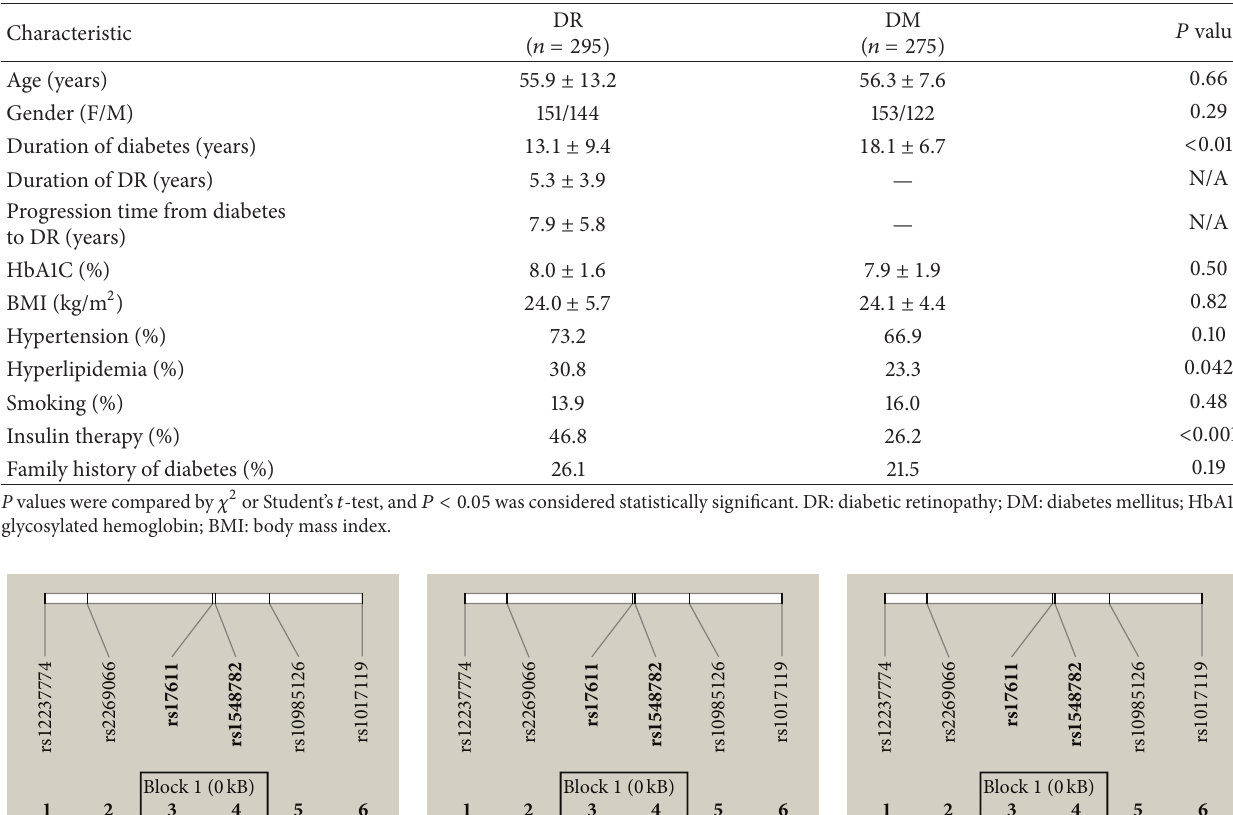
Table 1: Characteristics of the study subjects.